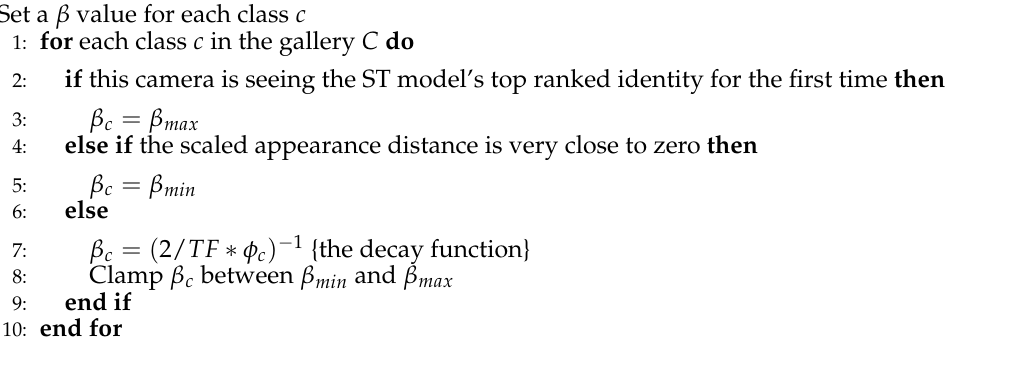
Algorithm 1 Computation and use of β , including the rule-based system to cover corner cases. Set a β value for each class